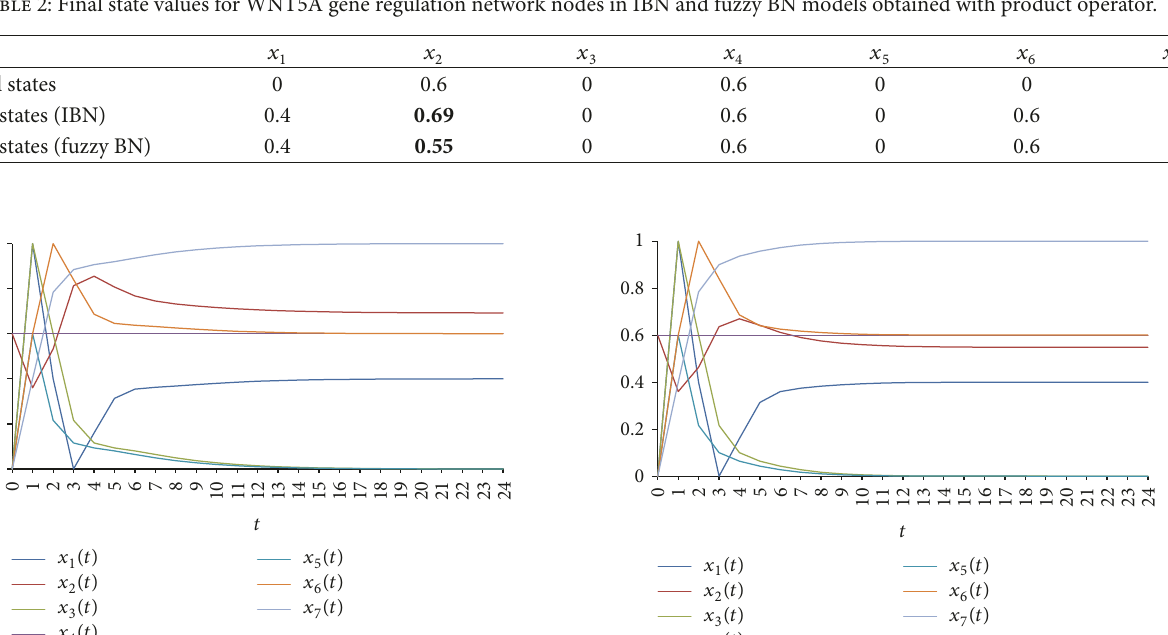
Table 2: Final state values for WNT5A gene regulation network nodes in IBN and fuzzy BN models obtained with product operator.